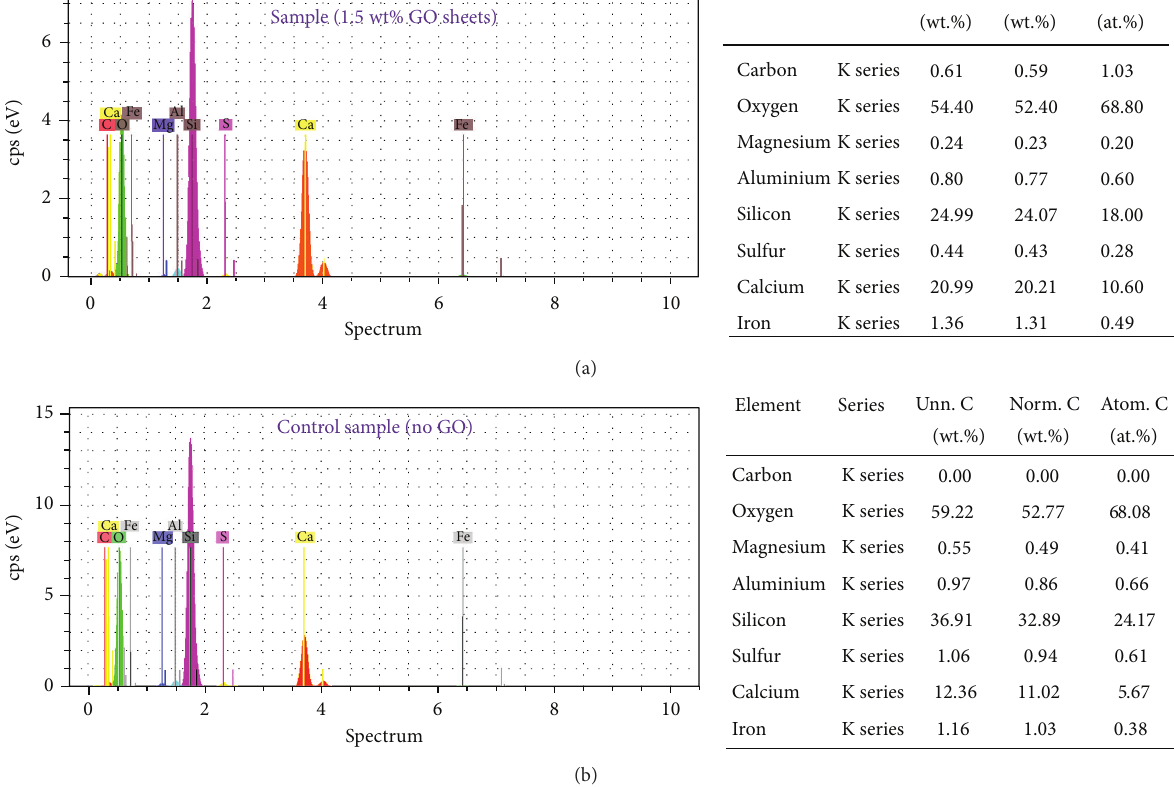
Figure 14: Composition of the GO-cement nanocomposites containing 1.5 wt% GO flakes (a) and control sample (b) (without any GO flakes) after 28 days, measured by energy dispersive analysis by X-ray